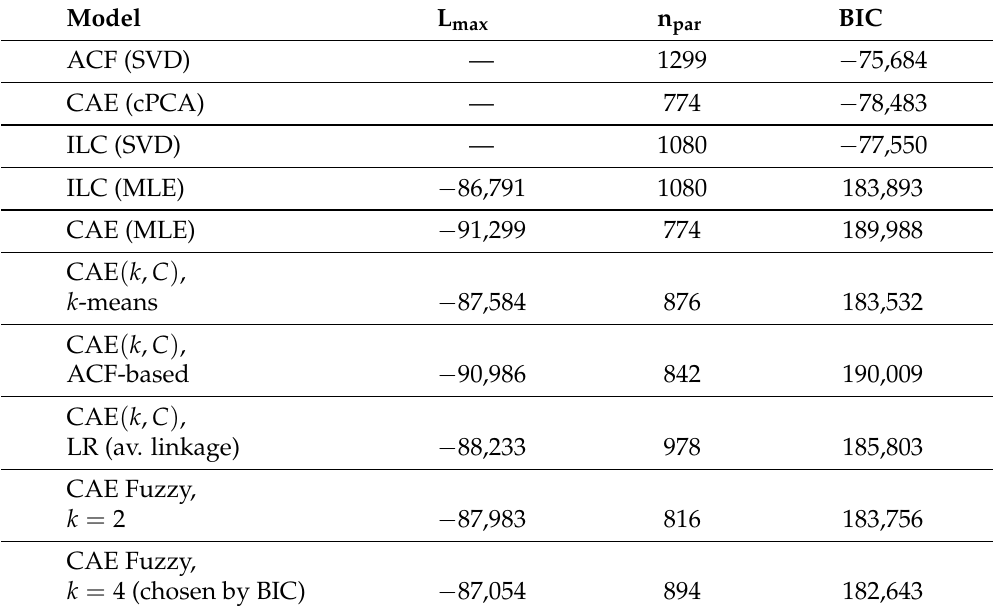
Table 2. The BIC and its components (maximal log-likelihood L max and free number of parameters n par ) for males aged 53 to 87 in 10 countries between 1948 and 1987. The BIC values for the models fitted by Poisson MLE are not directly comparable to those for the models fitted by singular value decomposition (SVD)/common principal components analysis